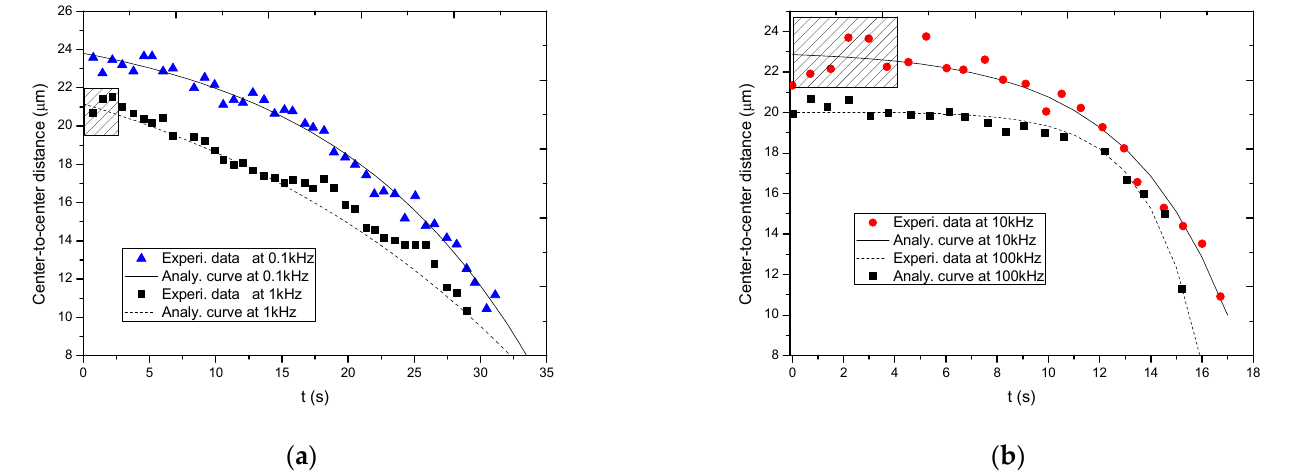
Figure 6. Fitting of the experimental data with the analytical solution. ( a ) Frequency of 0.1 kHz and 1 kHz. ( b ) Frequency of 10 kHz and 100 kHz.